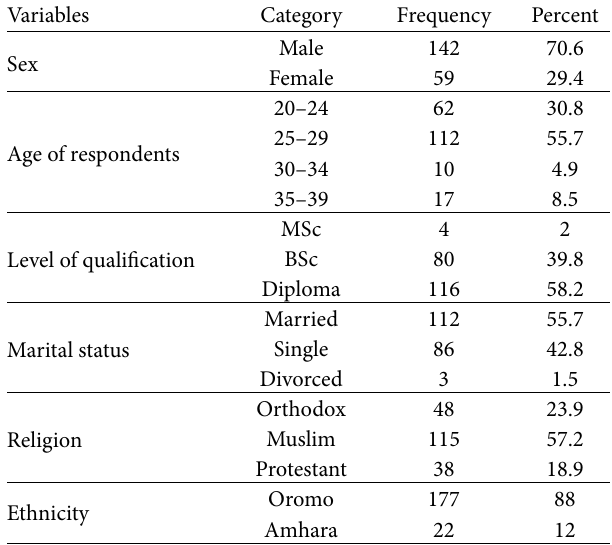
Table 2: Distribution of Training related and factors affecting the implementation of the IMNCI strategy among health care professionals in public health institution of Yifat cluster, North Shewa zone April, 2016. ( 𝑛 = 201